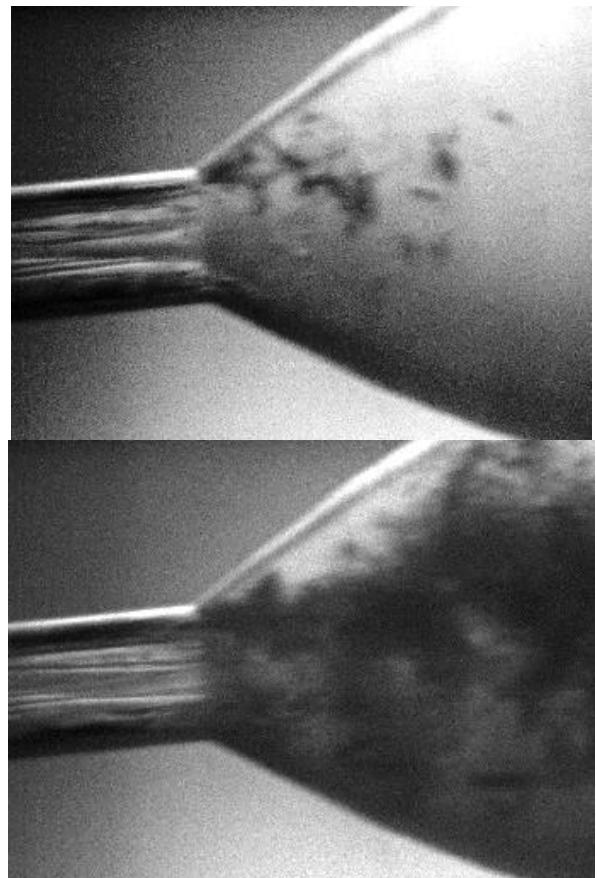
Figure 2. Two different regimes of cavitation ( up : incipient cavitation; down : fully developed cavitation) observed in the experimental works of Capocelli et al. [39].